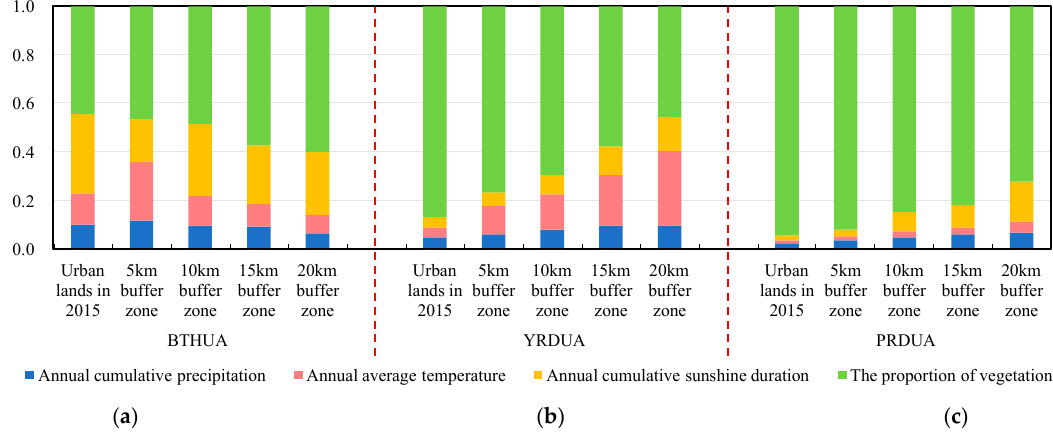
Figure 11. The importance to NPP of the annual cumulative precipitation, the annual average air temperature, the annual cumulative sunshine duration, and the proportion of vegetation in urban lands in 2015, also including the 5 km buffer zone, 10 km buffer zone, and 20 km buffer zone of ( a ) the BTHUA, ( b ) the YRDUA, and ( c ) the PRDUA.